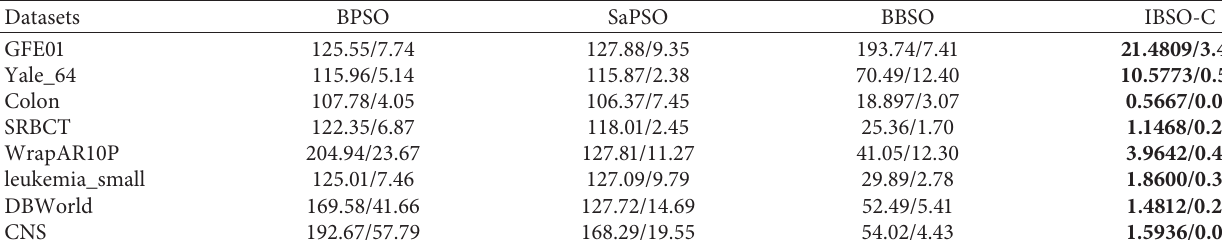
Table 6: Running time consumed by the four evolutionary FS algorithms (unit: